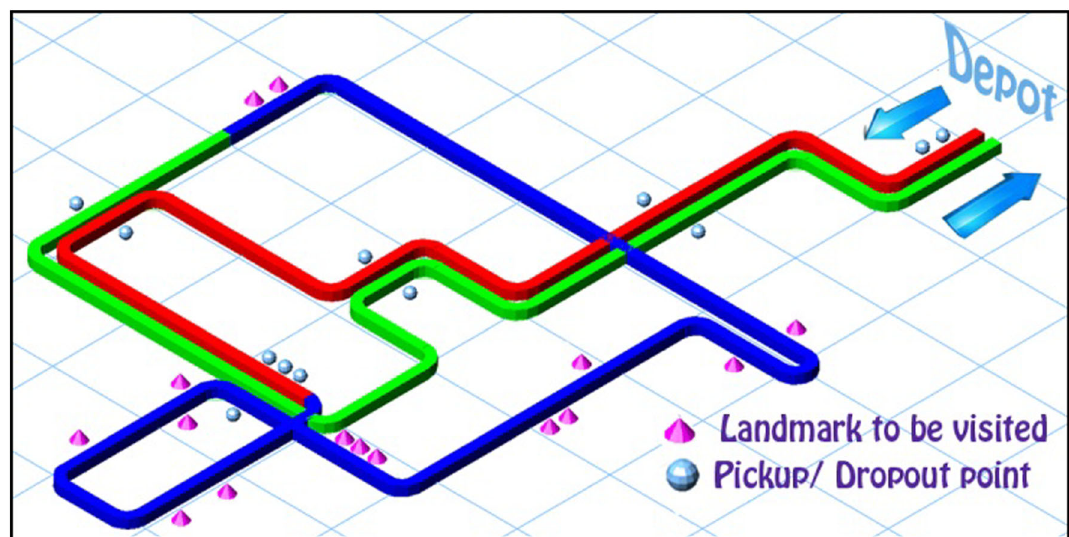
Fig. 4 A typical tour of a city bus in three stages: stage 1 ( red colored ) collecting tourists from pickup points, stage 2 ( blue colored ) visiting places of interest and stage 3 ( green colored ) dropping out